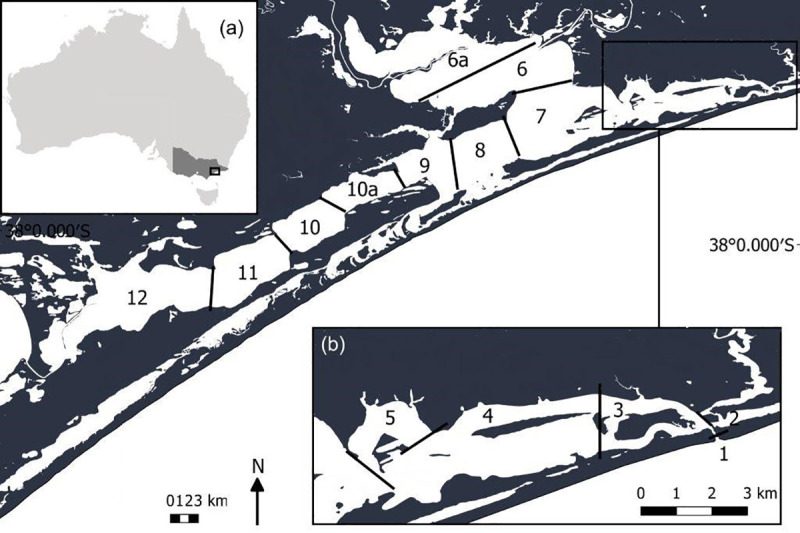
Map of Gippsland Lakes, Australia, showing zones allocated for the study.